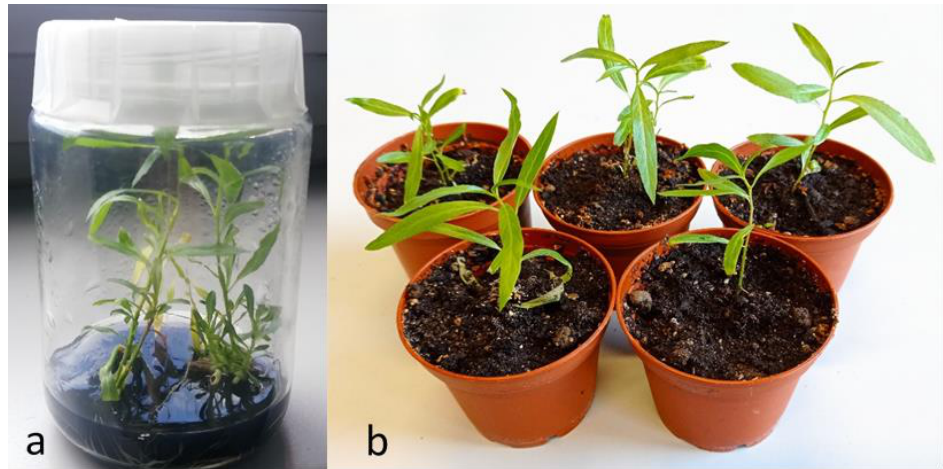
Figure 1. ( a ) In vitro shoot development of S. acmophylla on AC-containing WPM; ( b ) rooted plantlets of S. acrophyll, two weeks after acclimatization.